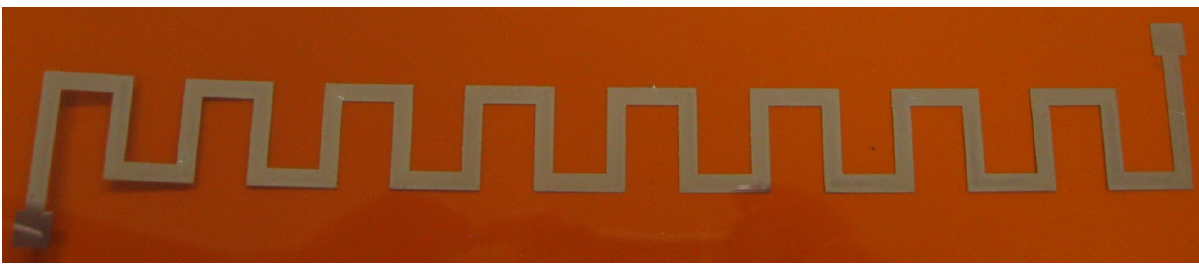
Figure 5. Printed unrolled rotor inductor.